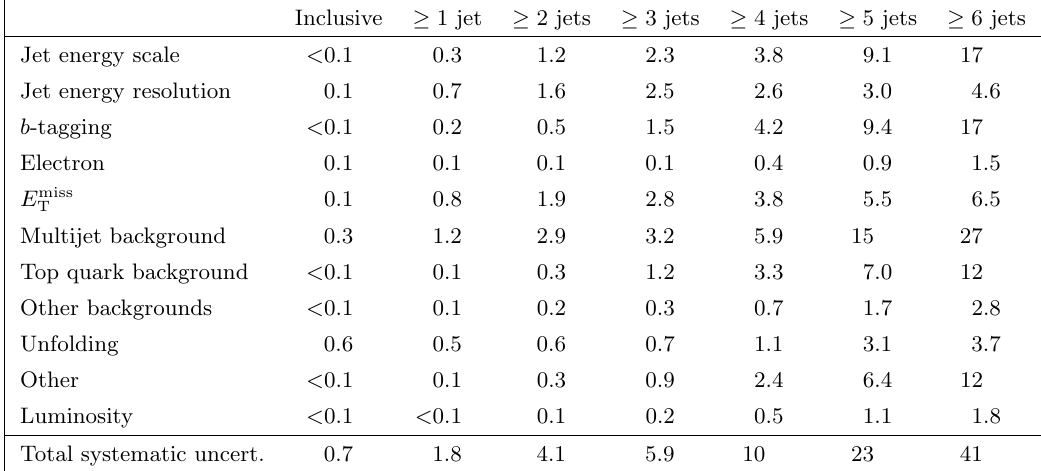
Total systematic uncert. Table 4 . Relative systematic uncertainties in the measured ( W + + jets)/( W (cid:0) + jets) cross-section ratio in percent as a function of the inclusive jet multiplicity. The uncertainty from b -tagging includes the uncertainties in the b -tagged jet identi(cid:12)cation and misidenti(cid:12)cation e(cid:14)ciencies as well as the impact of W + c; c (cid:22) c; b (cid:22) b cross sections in the extrapolation from the signal region to the (cid:12)ducial region. Other backgrounds summarizes the impact of Z and diboson cross sections as well as the statistical uncertainty in the background estimates. Other combines uncertainties in the pileup modelling and the impact of matching jets to the primary vertex.